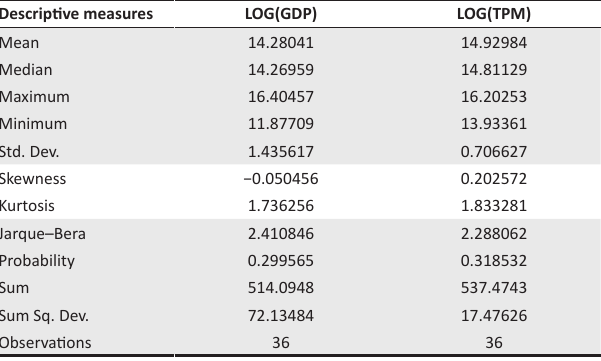
TABLE 1: Descriptive statistics for the sample period.